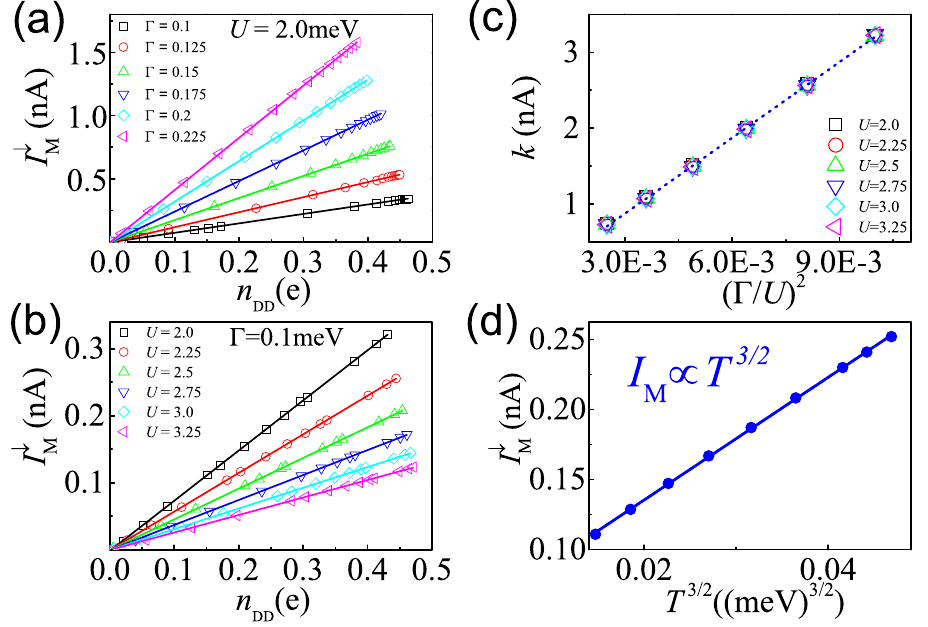
Figure 3. The curves of ↓ I as a function of the self-consistent n DD are shown, for different Γ in ( a ), and different M U in ( b ). The energy unit in all figures is meV. In ( a ), eV = U = 2.0 meV. In ( b ), eV = U and Γ = 0.1 meV. The scattered symbols are located by numerical data and the straight lines are plots of the function =